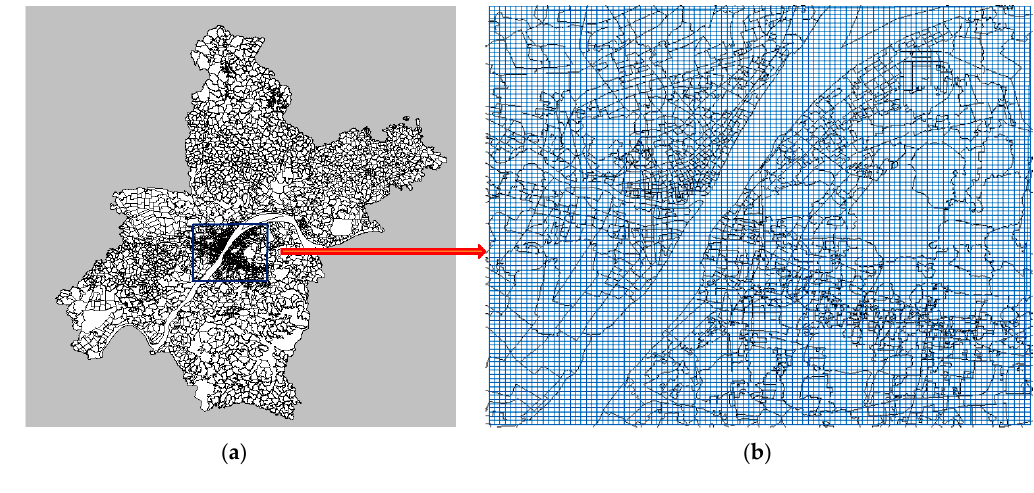
Figure 7. ( a ) Wuhan city ( b ) Grids of the Study Area.